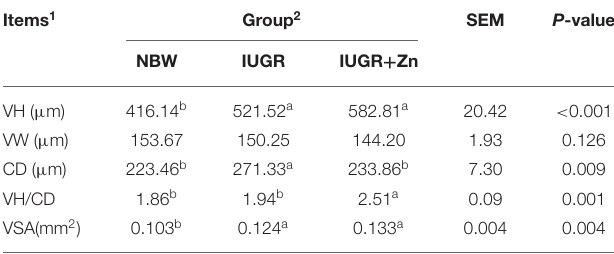
TABLE 3 | Effects of dietary Nano-ZnO supplementation on jejunal morphology of IUGR finishing